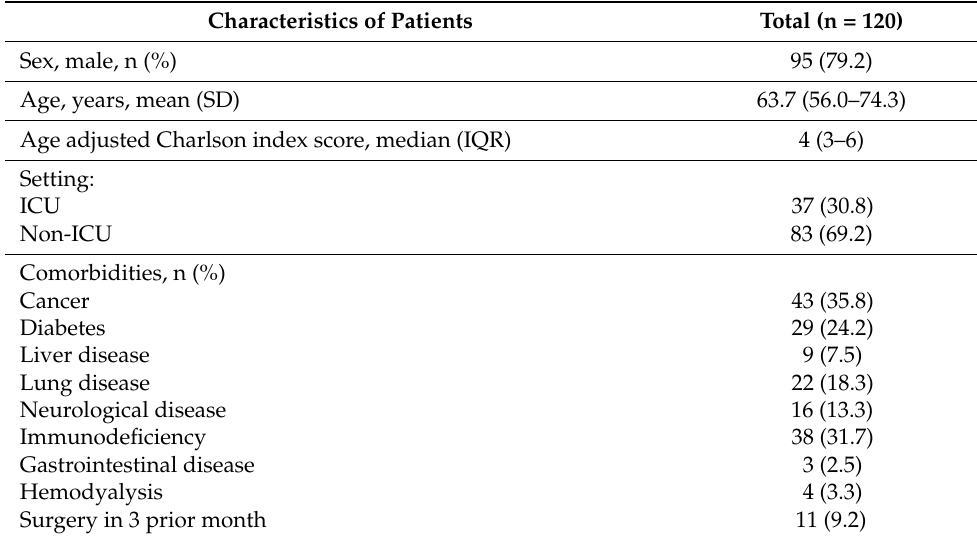
Table 1. Baseline characteristic of patients with bacteremia produced by